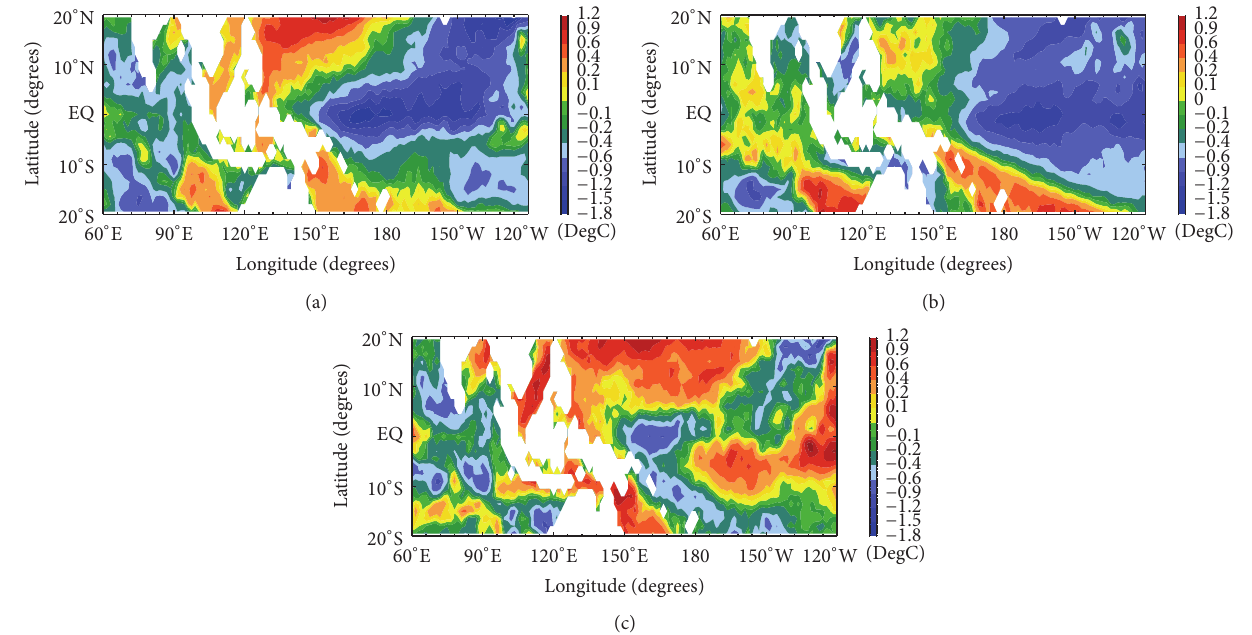
Figure 5: The spatial distributions of SSTs during the “prewarming” (a) and “postwarming” (b) periods. (c) Same as Figure 2(c) but for SST.